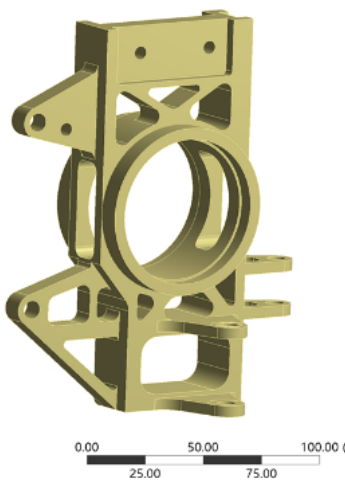
Figure 11. Final geometric model.